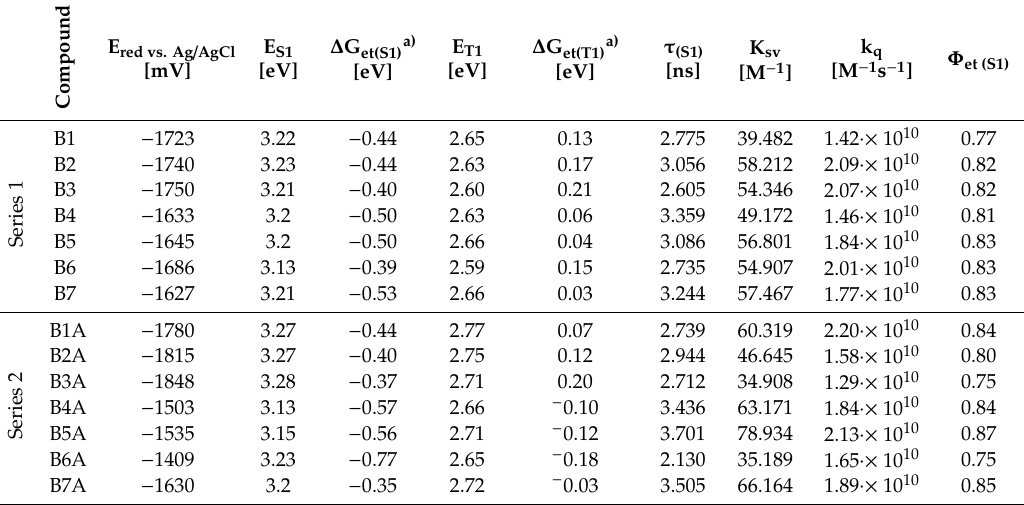
Electrochemical and thermodynamic properties of investigated 2-amino-4-methyl- 6-phenyl-benzene-1,3-dicarbonitrile derivatives in terms of their use in photo-reduction mechanism in light induces electron transfer